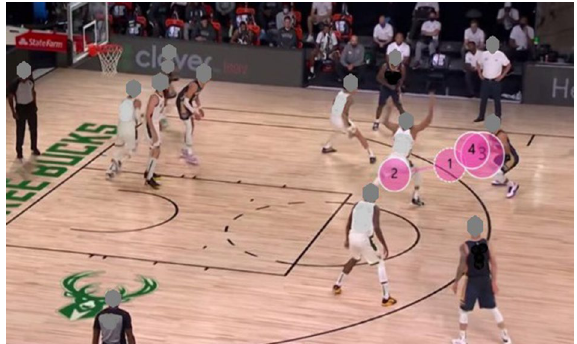
Figure 8. Example of Gaze Plot for experts.